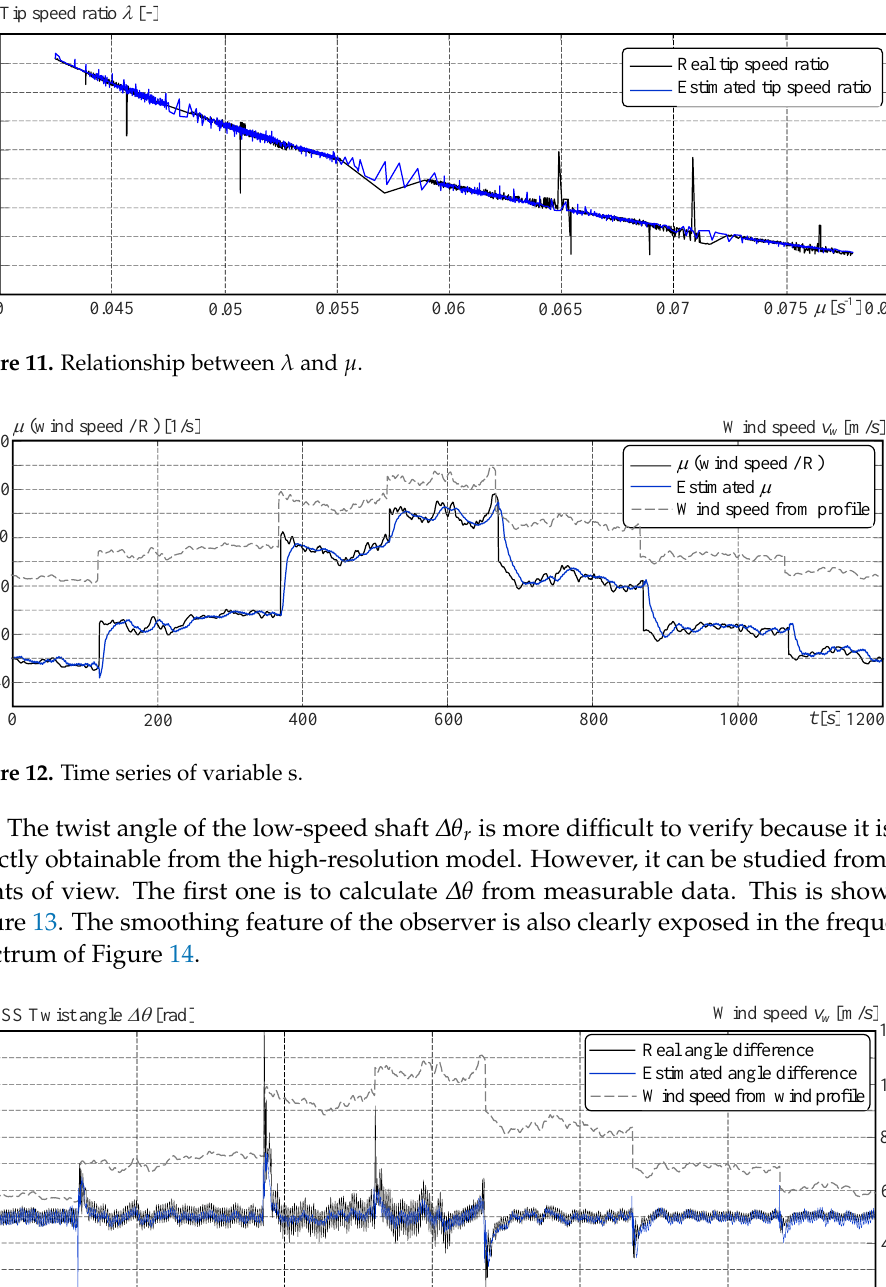
Figure 14. Single-side amplitude spectrum of the shaft twist angle. The other way is to use the rotor speed. Notice that the rotor speed is obtained from the third equation of (1) by using the derivative of the twist angle and the generator speed. The generator speed has a very high degree of agreement, because it is a measurable var- iable used as an input to the observer. Hence, the estimated rotor speed would be incorrect if the estimated derivative of the twist angle was erroneous. However, this is not the case, as can be appreciated in Figure 15 as well as in Table 4.